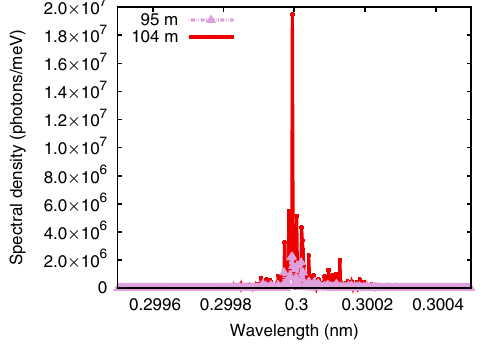
FIG. 14. Spectrum at saturation and past saturation of the (nonlinear) third harmonic for a self-seeded beam line tuned to a fundamental of 0.9 nm.